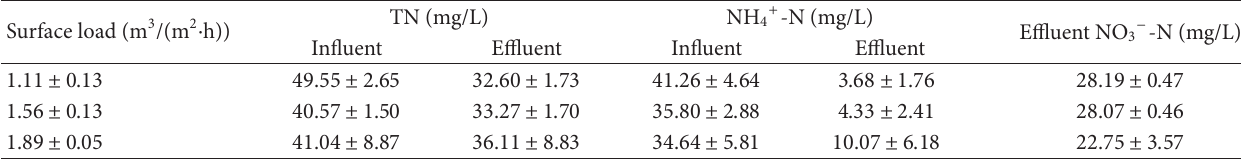
T 1: Nitrogen removal in a DSTR at different surface loads.